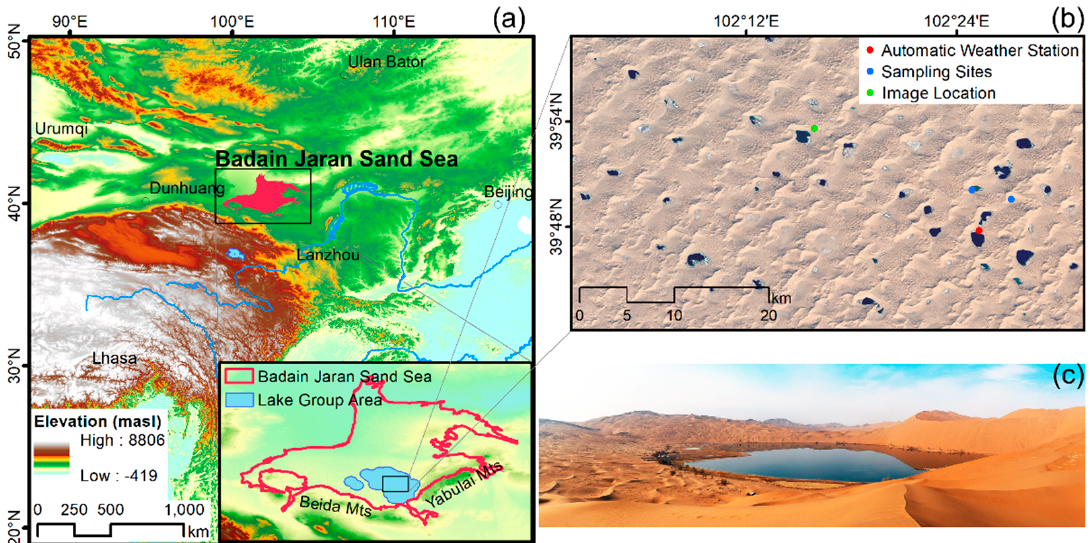
Figure 1. ( a ) Location of the Badain Jaran Sand Sea. ( b ) Location of the automatic weather station and sampling sites. The image location is marked with a green dot. ( c ) Coexistence of lakes and dunes in the Badain Jaran Sand Sea.